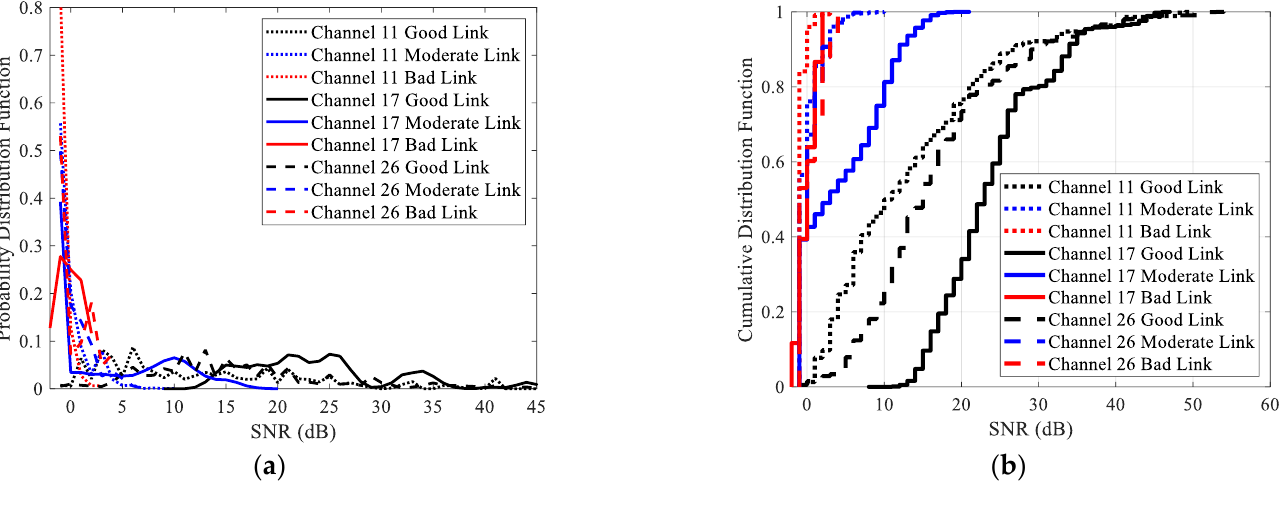
Figure 7. The distributions of SNR for good links, moderate links, and bad links under the interference-free channel 26, the low interference channel 11, and the high interference channel 17: ( a ) PDF; ( b ) CDF.